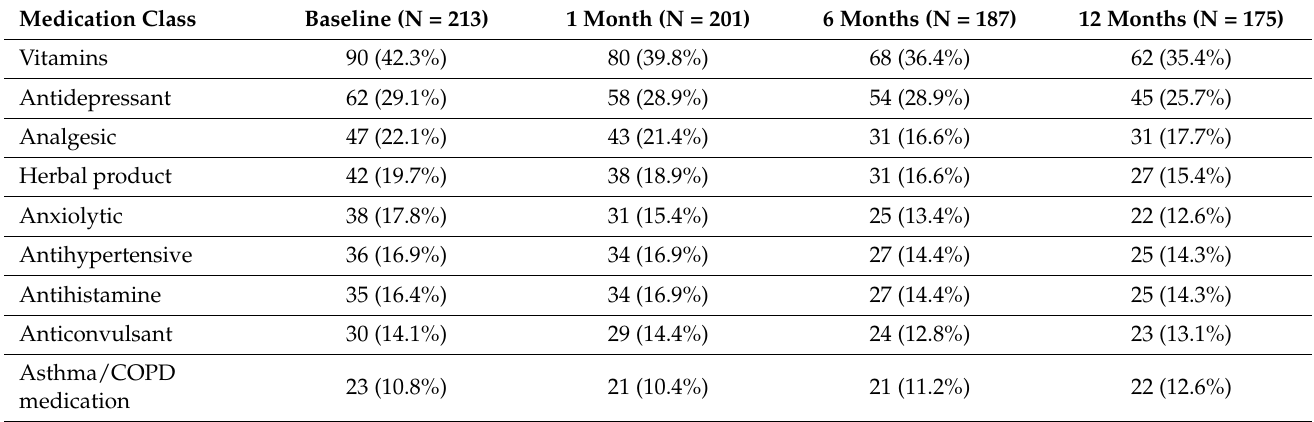
Table 3. Most Commonly Used